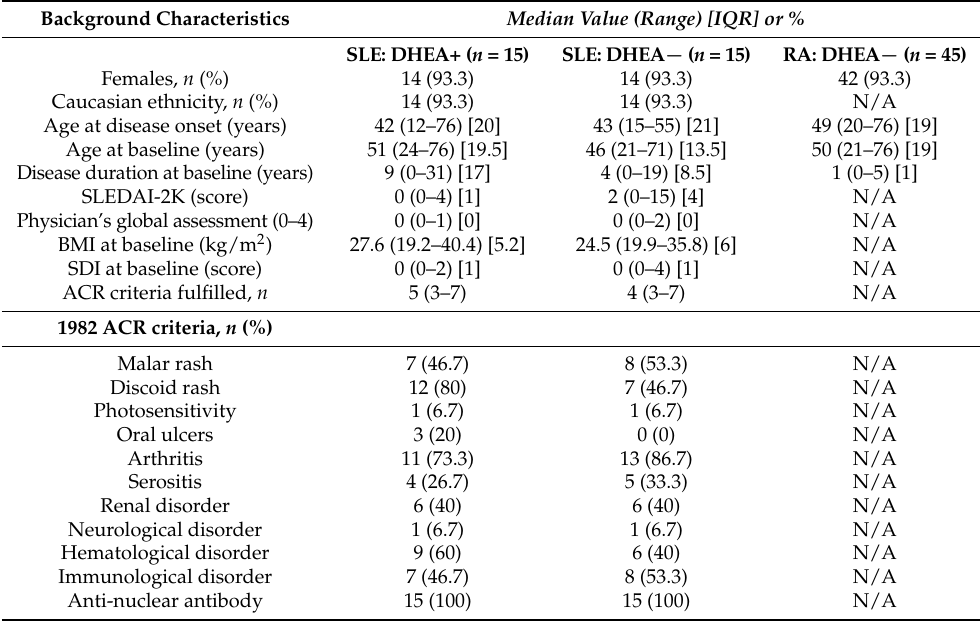
Table 1. Characteristics of the included